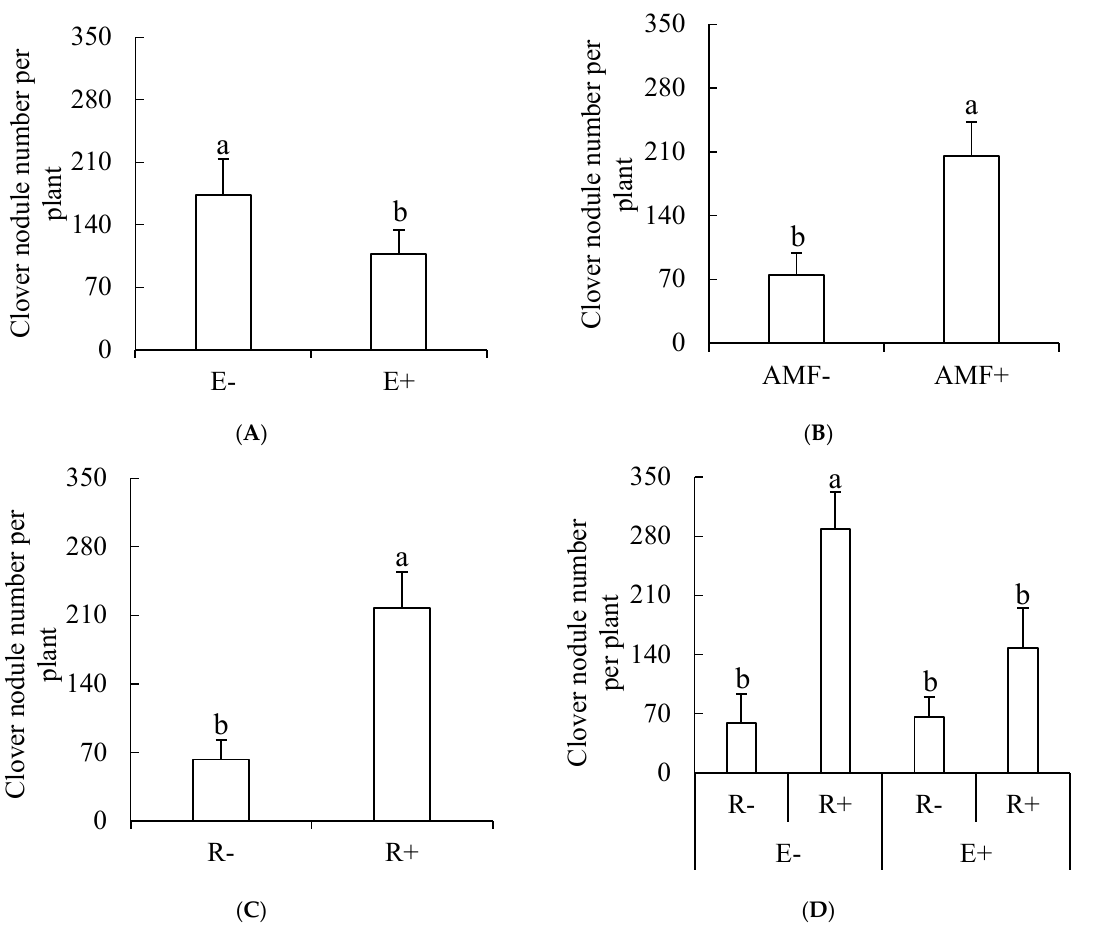
Figure 1. ( A – D ) The influence of endophytic fungi, AMF and rhizobia on the number of nodules. E+, endophyte-infected tall fescue; E − , endophyte-free tall fescue; AMF+, AMF-inoculated; AMF − , AMF-free; R+, rhizobia-inoculated; R − , rhizobia-free. Different small letters indicate significant differences between treatments ( p < 0.05).